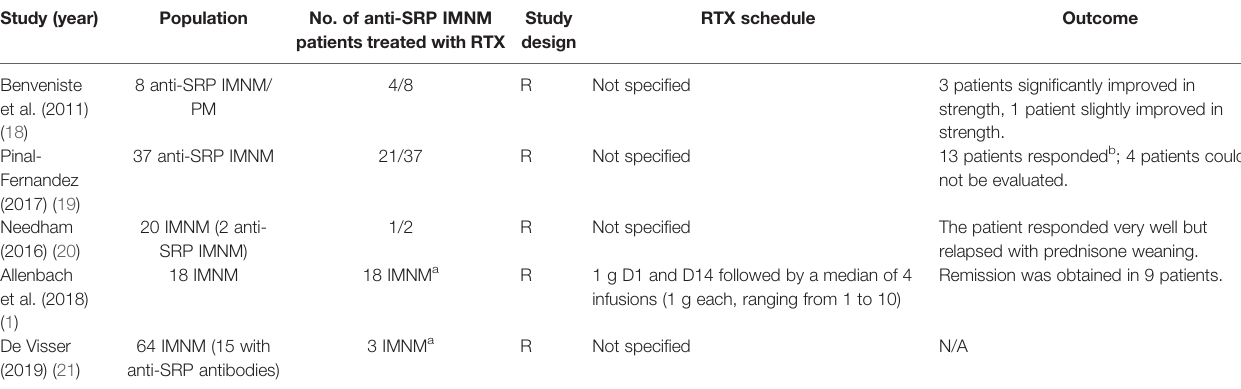
TABLE 4 | Literature review of studies on anti-SRP IMNM patients treated with anti-B-cell therapies. Study (year) Population No. of anti-SRP IMNM Study patients treated with RTX